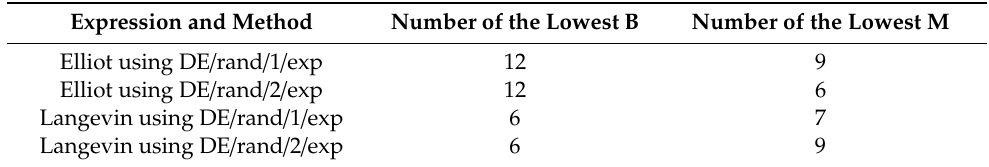
Table 8. Numbers of lowest B and M achieved using DE / rand / 1 / exp and DE / rand / 2 / exp for the Elliot and Langevin